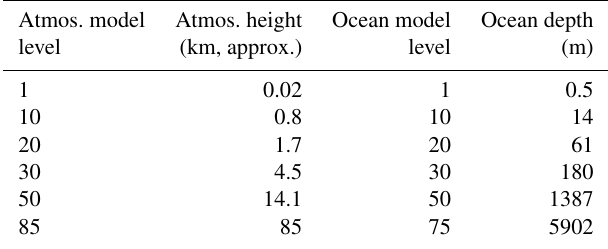
Table 1. A selection of model levels in the atmosphere and ocean and their corresponding